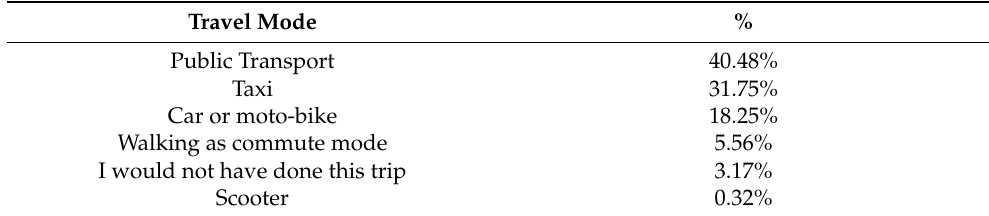
Table 7. Survey responses to “What mode(s) of transportation would you have taken if car-sharing was not available for this trip?” (N = 126, % of all car-sharing